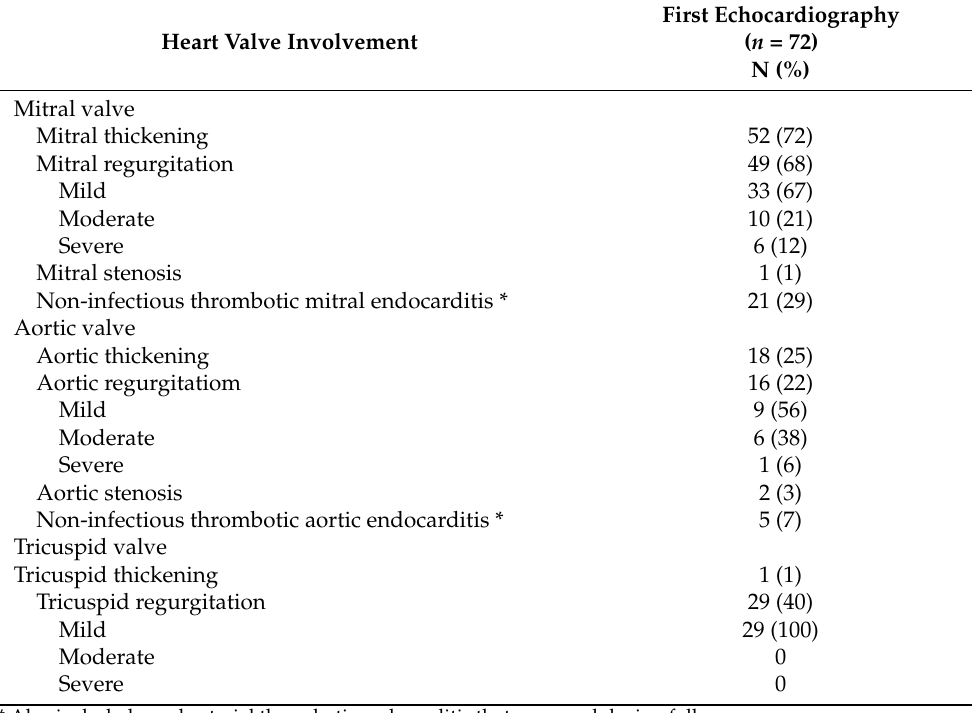
Table 3. Prevalence of valvular abnormalities on the first transthoracic echocardiography in patients with antiphospholipid syndrome.